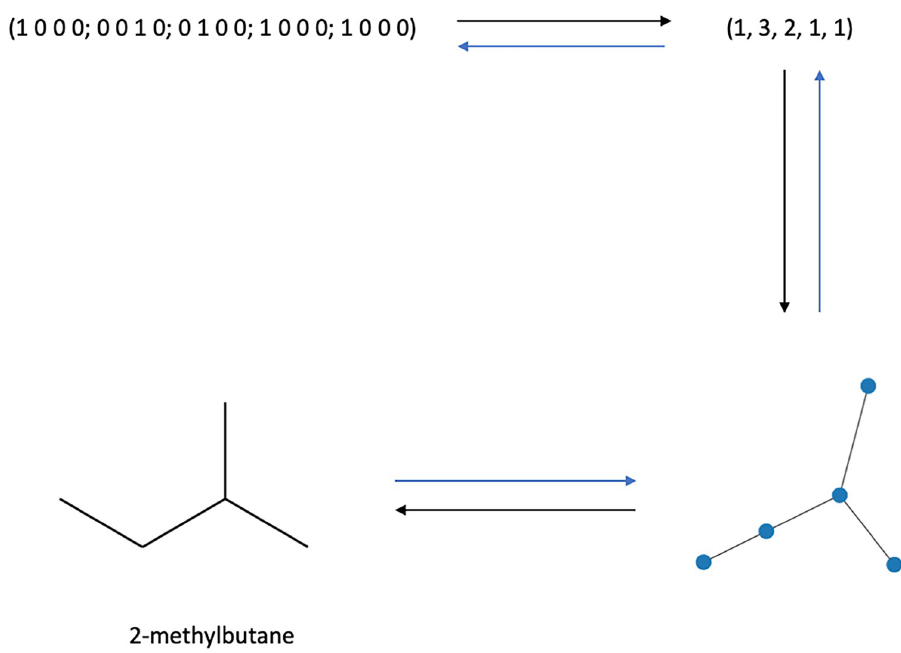
Fig 2. Encoding of 2-methylbutane. Representation of 2-methylbutane (an isomer of pentane C 5 H 12 ) as a one hot encoded bit string, degree sequence, graph, and molecular graph (clockwise from the top left).